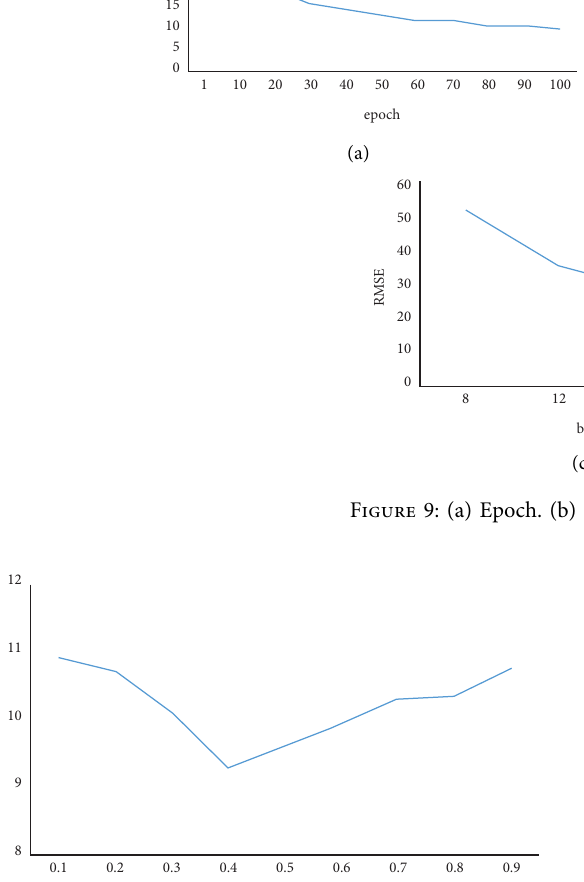
Figure 10: Te prediction results under diferent weights.